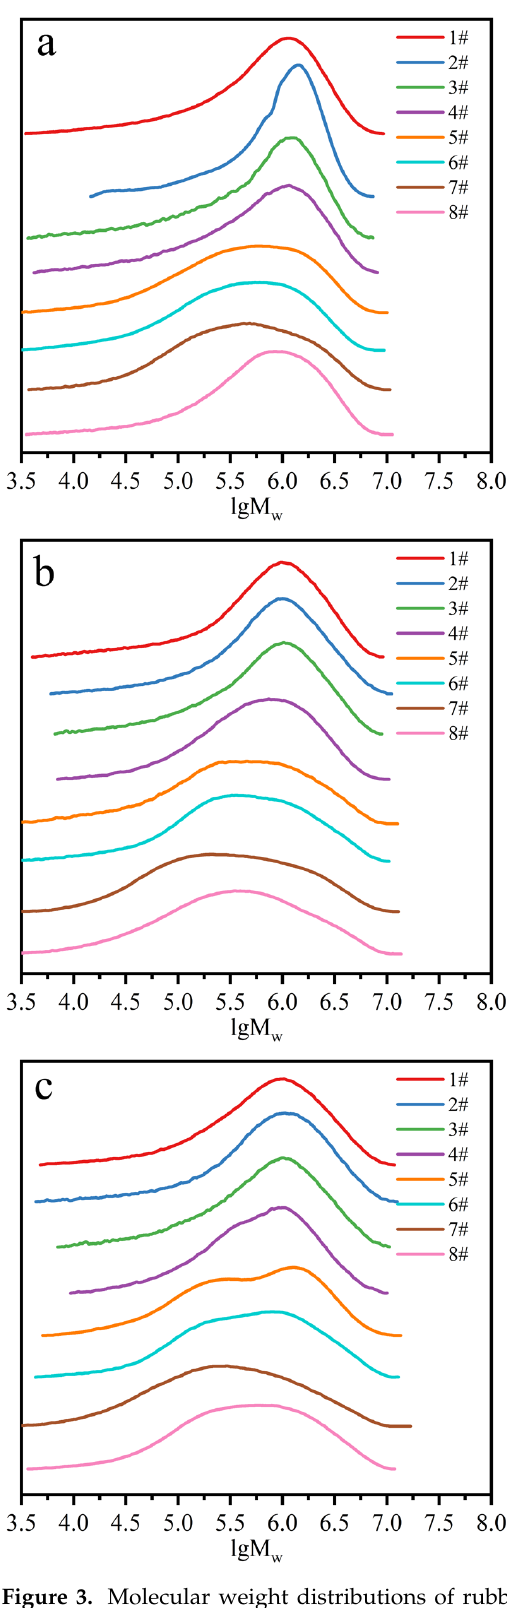
Figure 3. Molecular weight distributions of rubber films obtained from separated latexes from dif- ferent Hevea brasiliensis clones: ( a ) IAN873; ( b ) Dongfang93114; ( c ) Reyan73397.